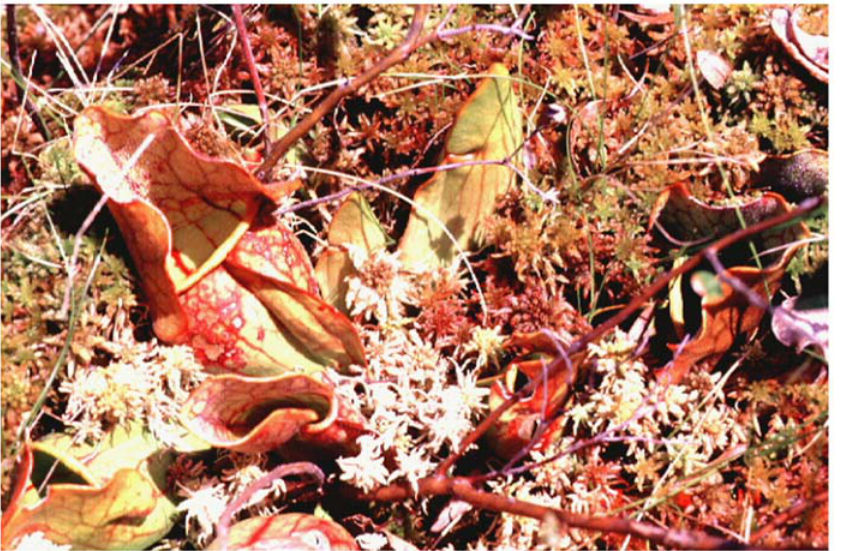
Figure 1. The pitcher plant Sarraceniapurpurea . This carnivorous plant grows as a rosette of leaves modified into pitchers that act as pitfall traps in which rainfall is collected and prey are captured.